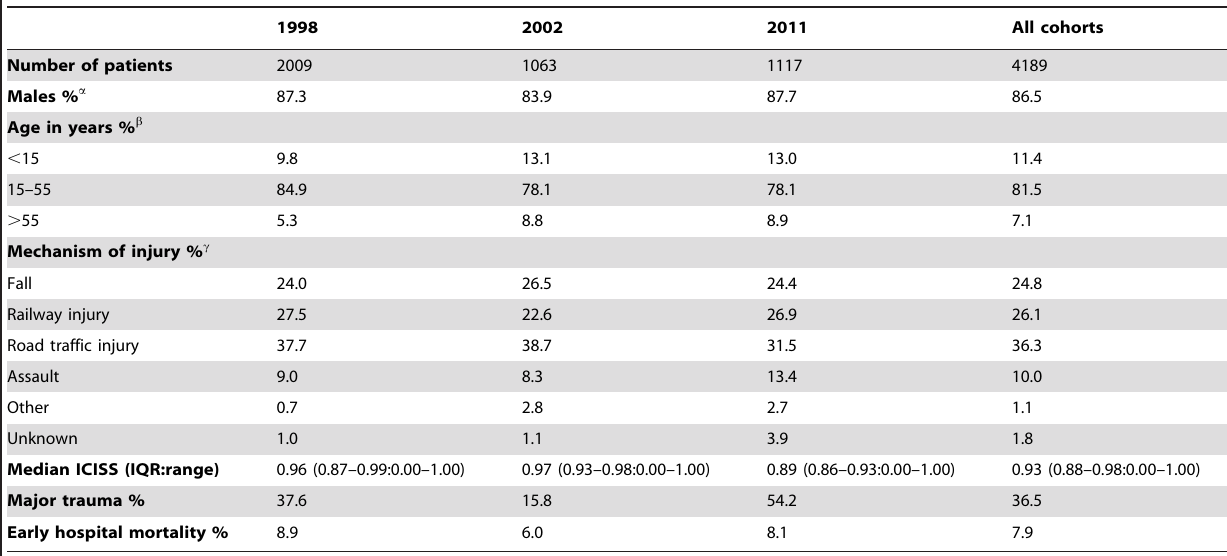
Table 2. Patient